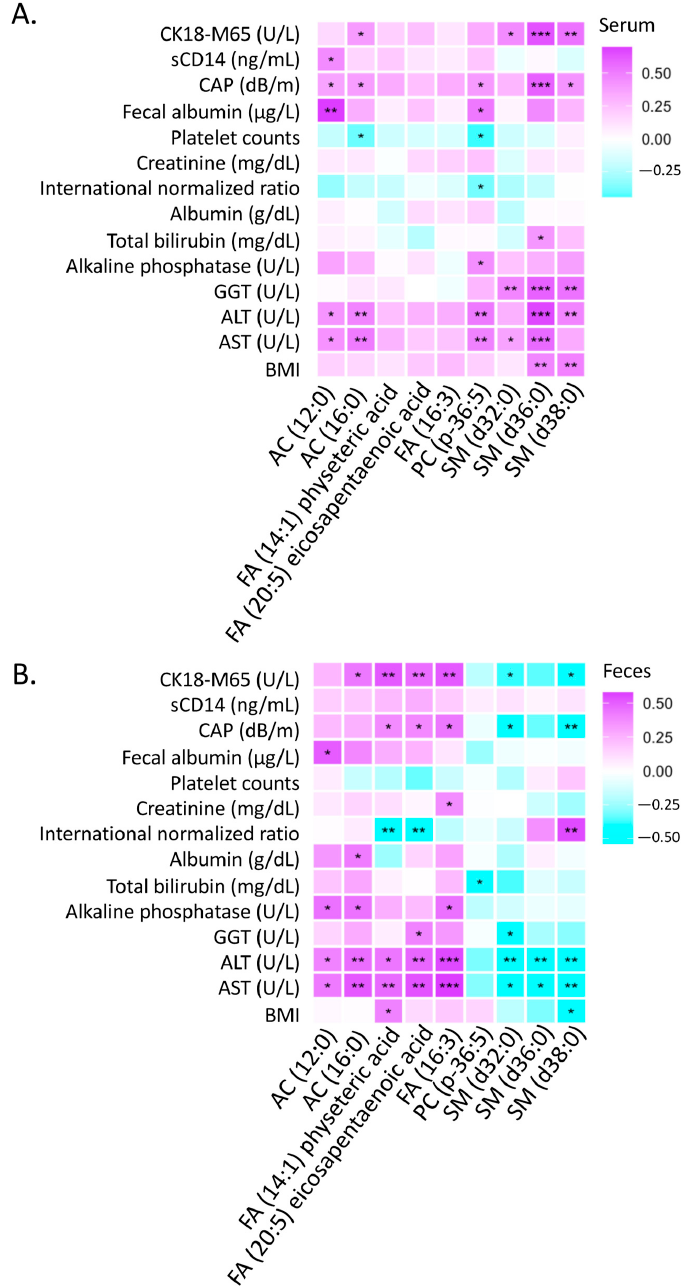
Figure 4. Spearman correlation between nine lipid biomarkers and clinical parameters. ( A ) Serum lipids. ( B ) Fecal lipids. *: p -value < 0.05; **: p -value < 0.01; ***: p -value < 0.001.